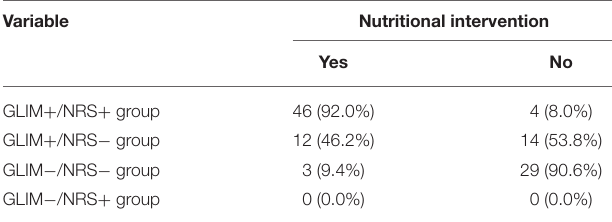
TABLE 5 | Results of nutritional intervention in different groups of patients with CD. Variable Nutritional